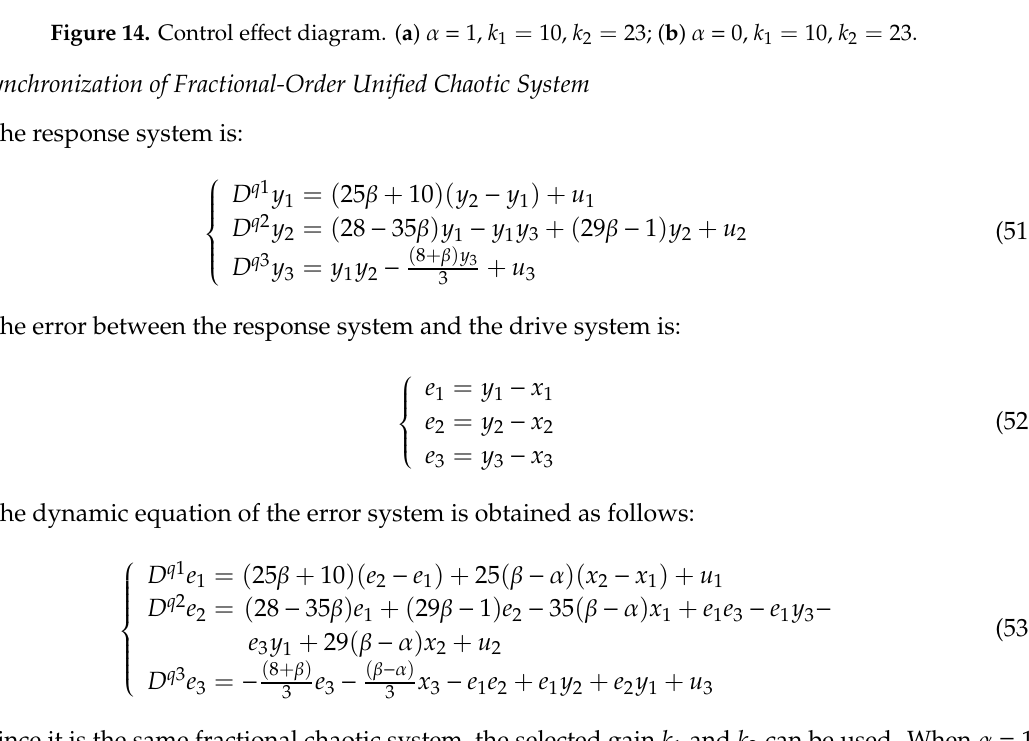
Figure 14. Control effect diagram. ( a ) α = 1, 𝑘 (cid:2869) = 10 , 𝑘 (cid:2870) = 23 ; ( b ) α = 0, 𝑘 (cid:2869) = 10 , 𝑘 (cid:2870) = 23 .